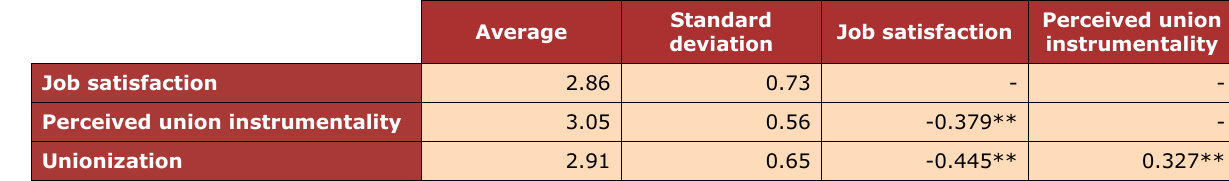
Table 1. Descriptive statistics and correlation coefficient of variables